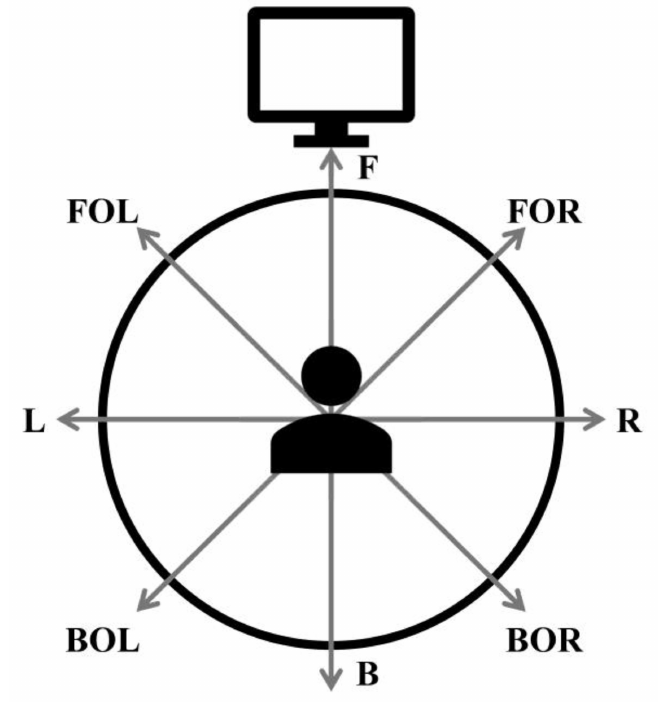
Figure 2. Schematic of the tilting directions of the device. B: back, BOL: back oblique left, BOR: back oblique right, F: front, FOL: front oblique left, FOR: front oblique right, L: left, and R: